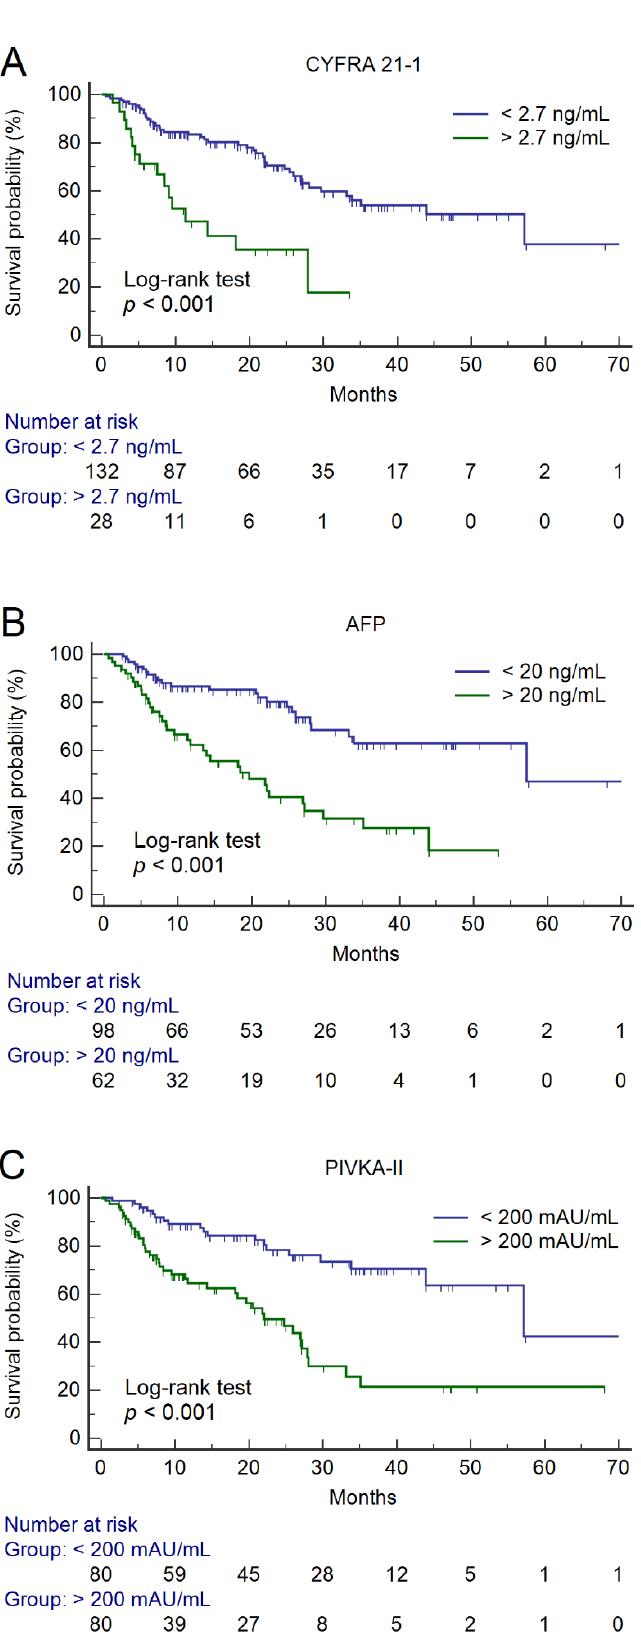
Figure 2. Survival curves according to baseline values of CYFRA 21-1 ( A ), AFP ( B ), and PIVKA-II ( C ). Abbreviations—alpha-fetoprotein (AFP) and protein induced by vitamin K absence or antagonist II (PIVKA-II).